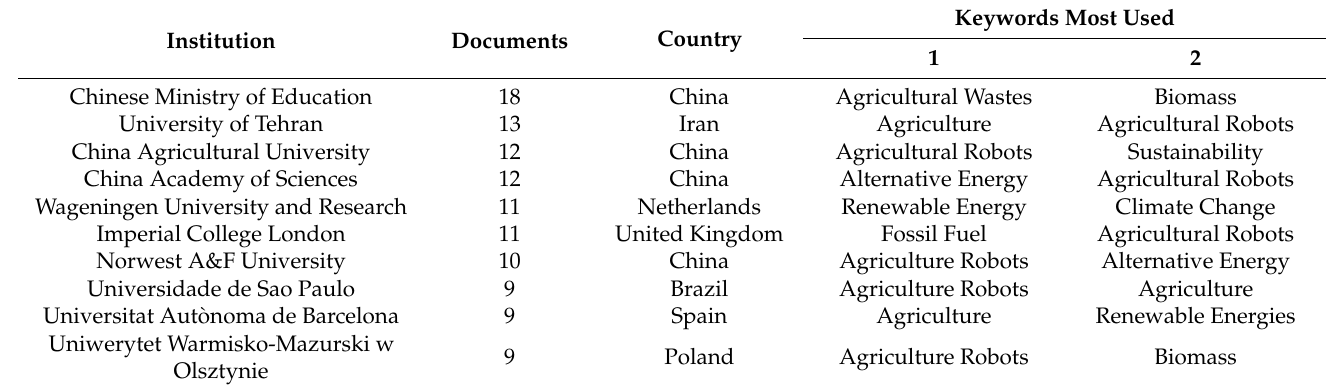
Table 2. Ten most productive institutions in terms of research into renewable energy and agriculture